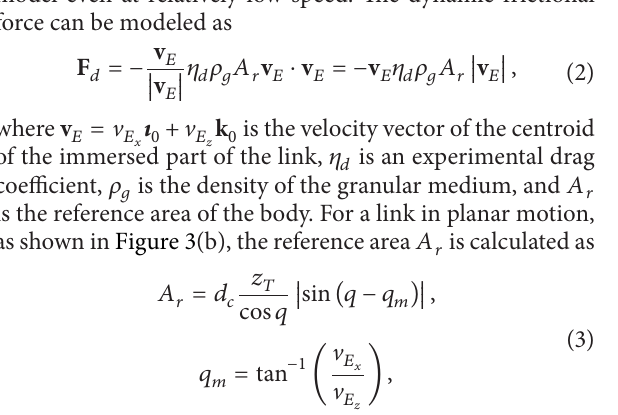
one angular position 𝑞 are selected as generalized coordi- nates of the model. For a flexible free link, the generalized coordinates include the rigid body coordinates and 𝑛 elastic generalized